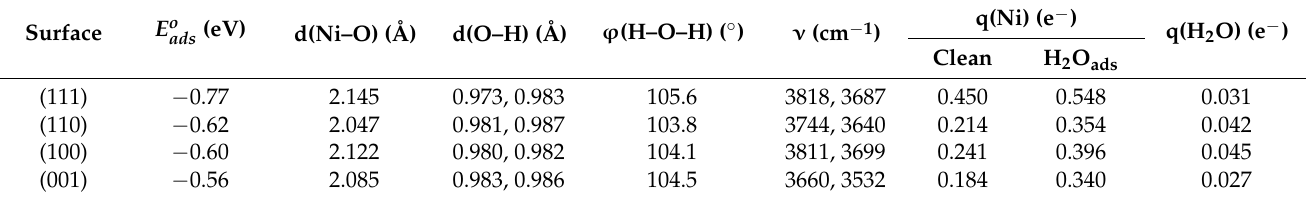
Table 1. ZPE-corrected adsorption energies ( E o ), distance between water and surface Ni (Ni–O), O–H bond length in ads water, bond angles of water ( ϕ ), and vibrational frequency of the symmetric and asymmetric stretch O–H stretches of water (where the molecular values were 3988 and 3866 cm − 1 ). Bader charges of the Ni active site before (clean) and after (H 2 O ads ) adsorption are included, as well as the Bader charge of adsorbed water (q(H 2 O)), where q(H 2 O) of molecular water was 0.